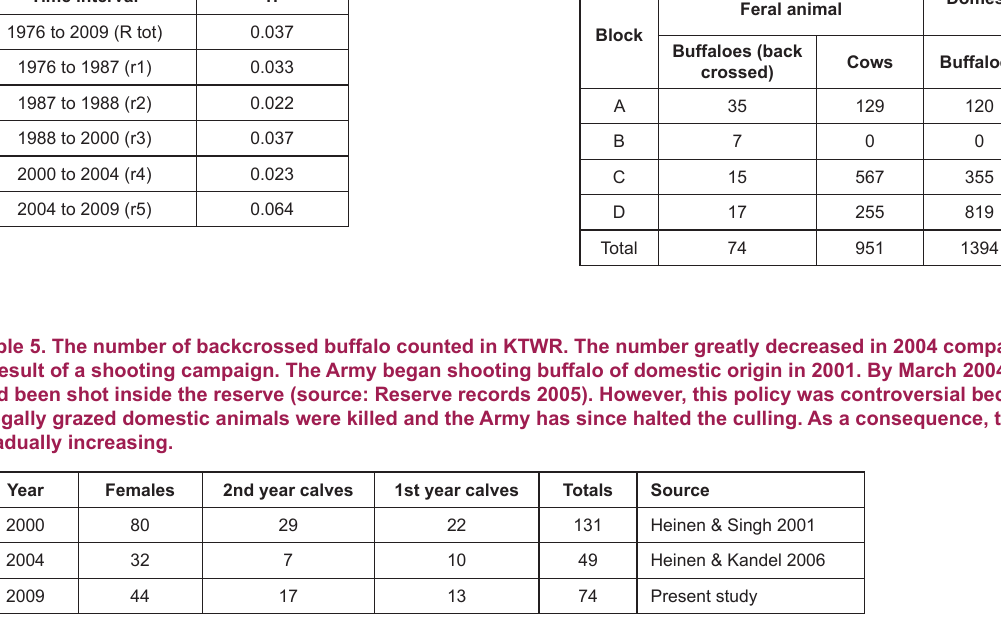
Table 4. The number of feral and domestic livestock inside KTWR counted in 2009 Domesticated animal Feral animal (cattle) Block